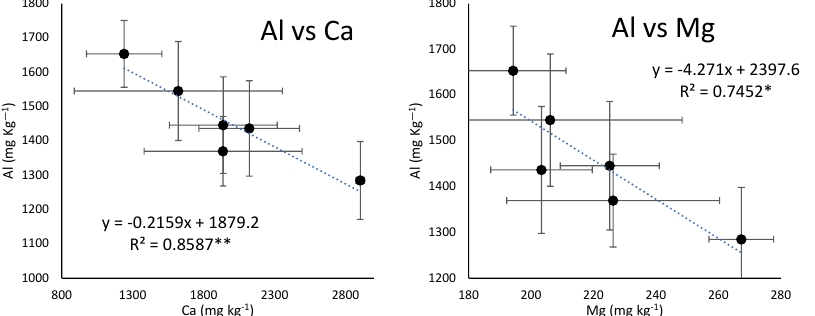
Figure 7. Relationships between years of ginseng cultivation and trace elements and soluble Al in the soil. Mean values ± standard errors ( n = 3). * Represents significance at the 0.05 probability level. Figure 8. Relationships between soluble Al and exchangeable Ca and Mg in the ginseng cultivation soils. Mean values ± standard errors ( n = 3). * Represents significance at the 0.05 probability level. ** Represents significance at the 0.01 probability level.